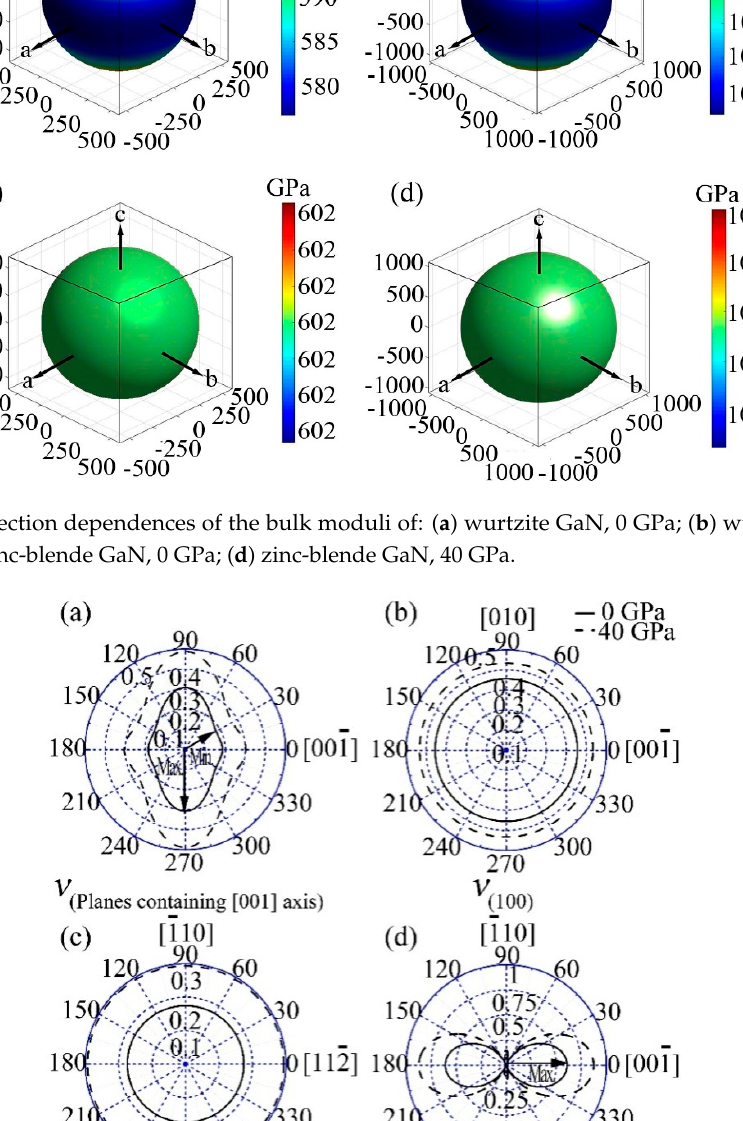
Figure 7. Poisson’s ratios of wurtzite GaN at planes containing [001] ([0001]) axis ( a ); and Poisson’s ratio of zinc-blende GaN at three crystal planes (100) ( b ), (111) ( c ) and (110) ( d ).